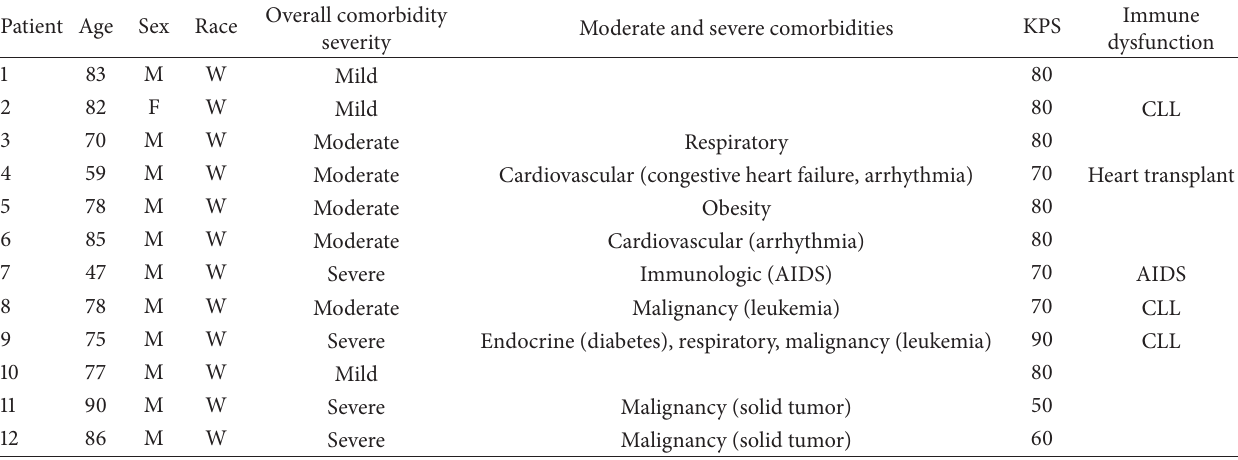
Table 1: Patient characteristics.